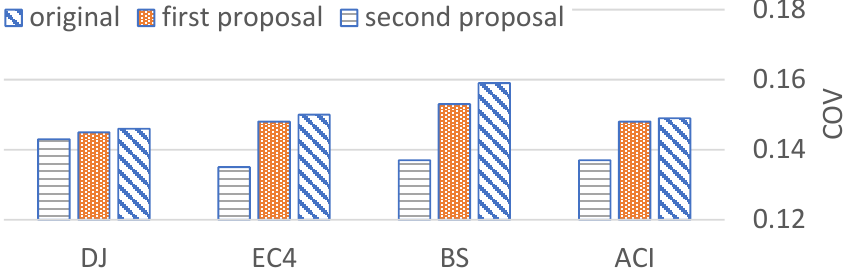
Figure 9. Comparison between the coefficient of variation of the existing and the proposed design approaches. Table 2. Comparisons of square and rectangular CFT stub column capacity produced using differ- ent equations with the experimental results.